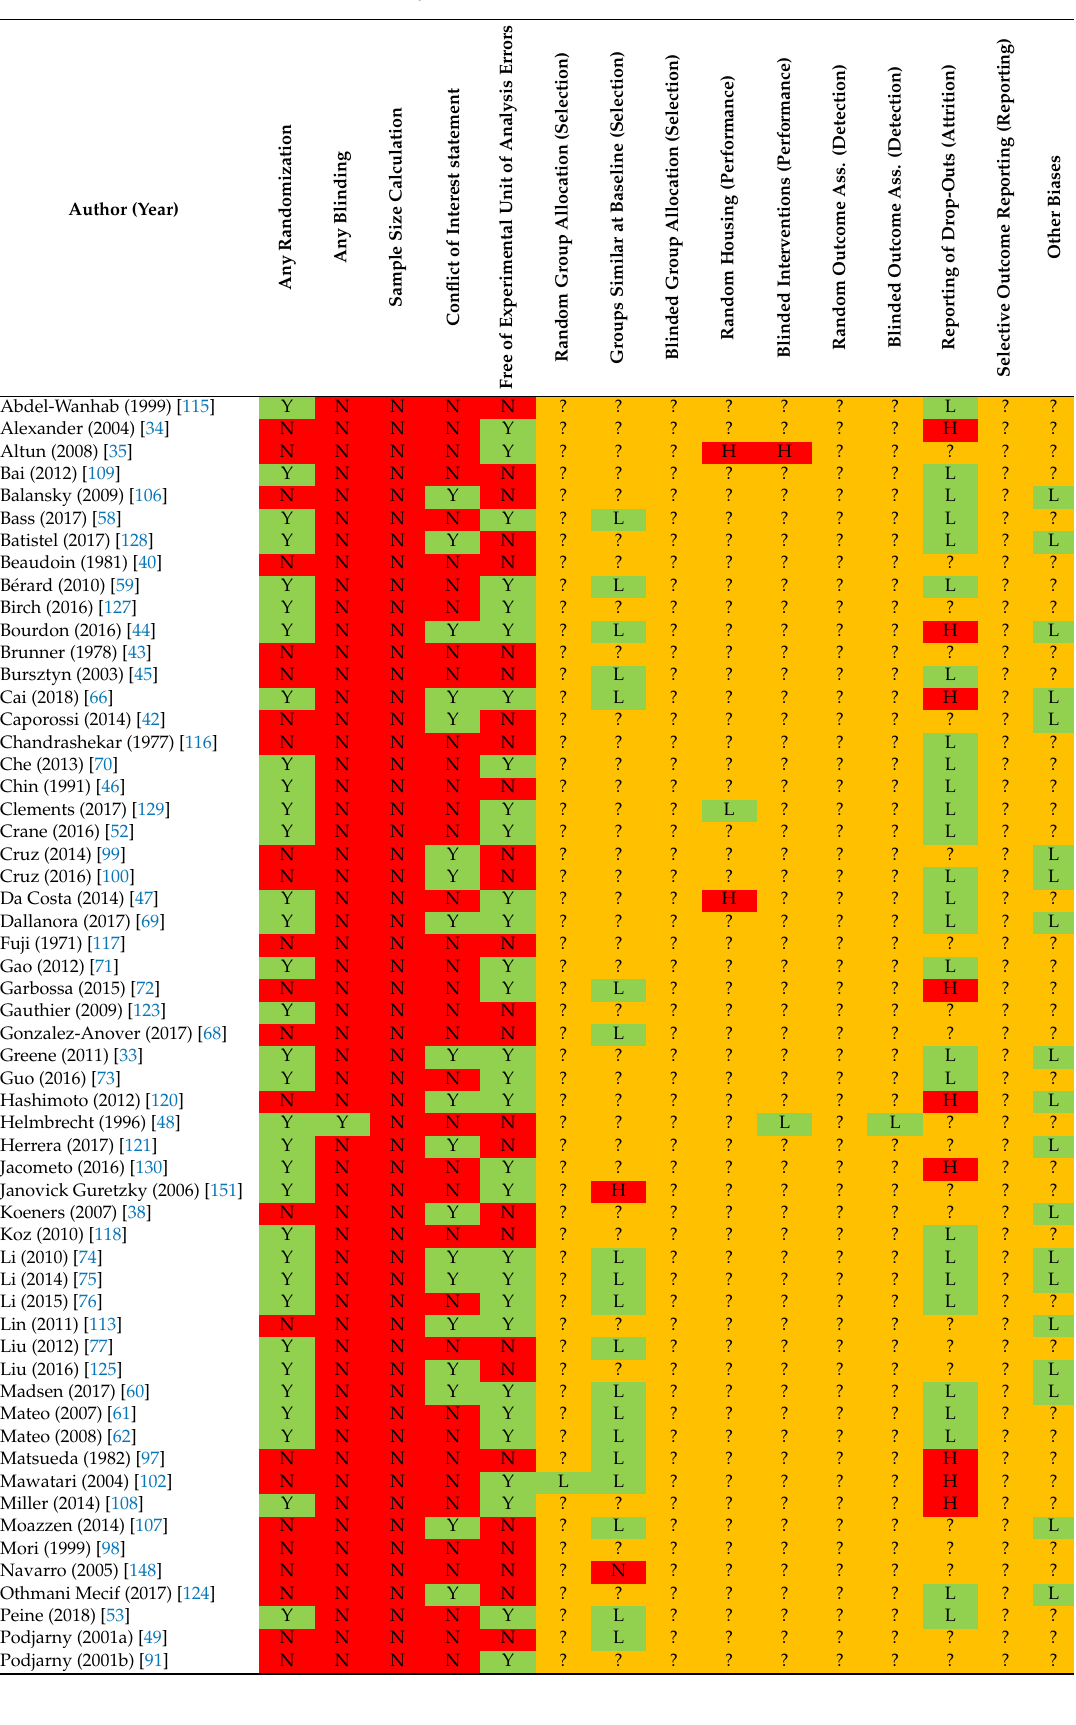
Table A10. Quality assessment of included animal